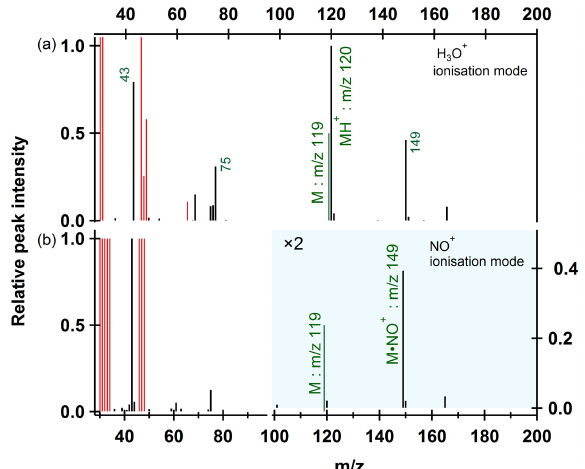
Figure 7. Recorded mass spectrum of protonated KnC3 (black bars) for E/N = 75Td, corresponding to the highest sensitivity for the protonated analyte signal detection ( m/z 120) in absence of the RF device (a) and in the NO + ionization mode in presence of the RF ( E/N ∗ = 40Td) (b) . The thin green line represents the expected molecular ion of the analyte. The intense signals depicted by the red thin bars represent the ionizing and matrix analytes at m/z = ) and their isotopic abundance signals at 30 (NO + ) and 46 (NO + 2 m/z = 31 and 47, 48 respectively. The signals corresponding to the water clusters (H 3 O + (H 2 O) n at m/z 37 and 55 are systematically erased for